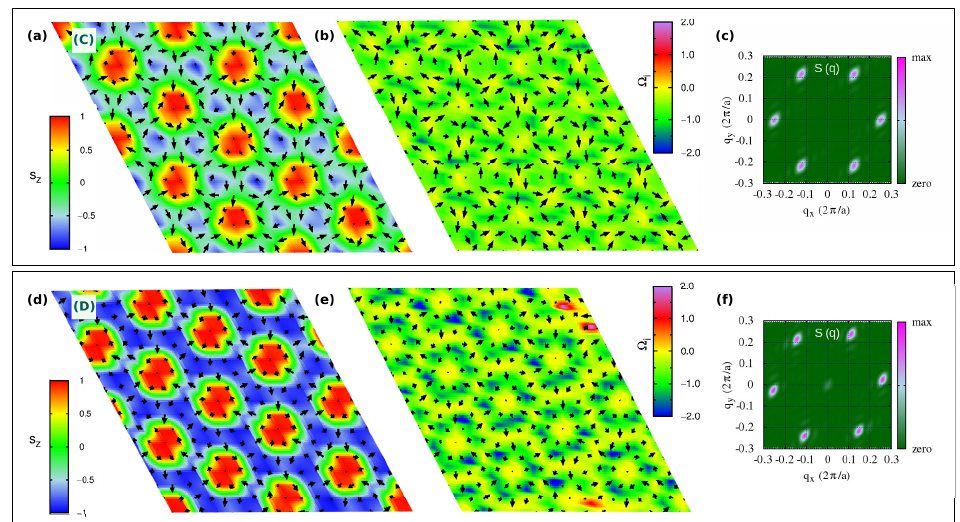
Figure 3. Topological lattices with | Q | m . u . c = 6. Snapshots at T = 1 K from Monte-Carlo simulations of real-space spin configurations ( a , d ) and corresponding topological charge densities Ω i ( b , e ), in sequence: black arrows represent in-plane { s x , s y } components of spins; colormap indicates the out-of-plane s z spins component in the first snapshot and Ω i in the second one. The associated spin structure factor S ( q ) is also shown ( c , f ). Capital letters on each spin configuration refer to the labels used in the phase diagram Figure 1c to name each spin configuration: C-phase refers to a triple-( q ) state, composed by periodic repetition of two vortices (V, m = + 1) and an anti-bi-vortex (A2V, m = − 2) with total Q = 2; D-phase refers to a triple-( q ) state, consisting of a quasi-ideal anti-bi-skyrmions (A2SK)